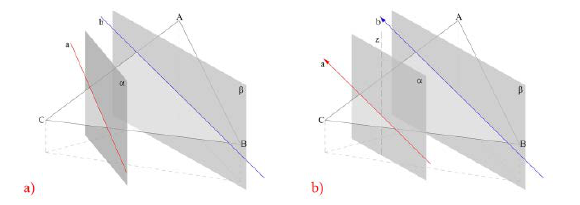
Figure 12. Geometric relationships to use spherical panoramas The first step is to find the only vertical plane α that yields the first condition, as demonstrated below and as illustrated in Figure 12. For this scope, one can use any inclined plane, denoted in Figure 12a by three points ABC, that intersects vertical plane α along line a and vertical plane β along line b. Making plane α rotate rigidly around a vertical axis z, the two lines a and b will be parallel with an improper point of intersection only when plane α is situated parallel to plane β (Figure 12b).